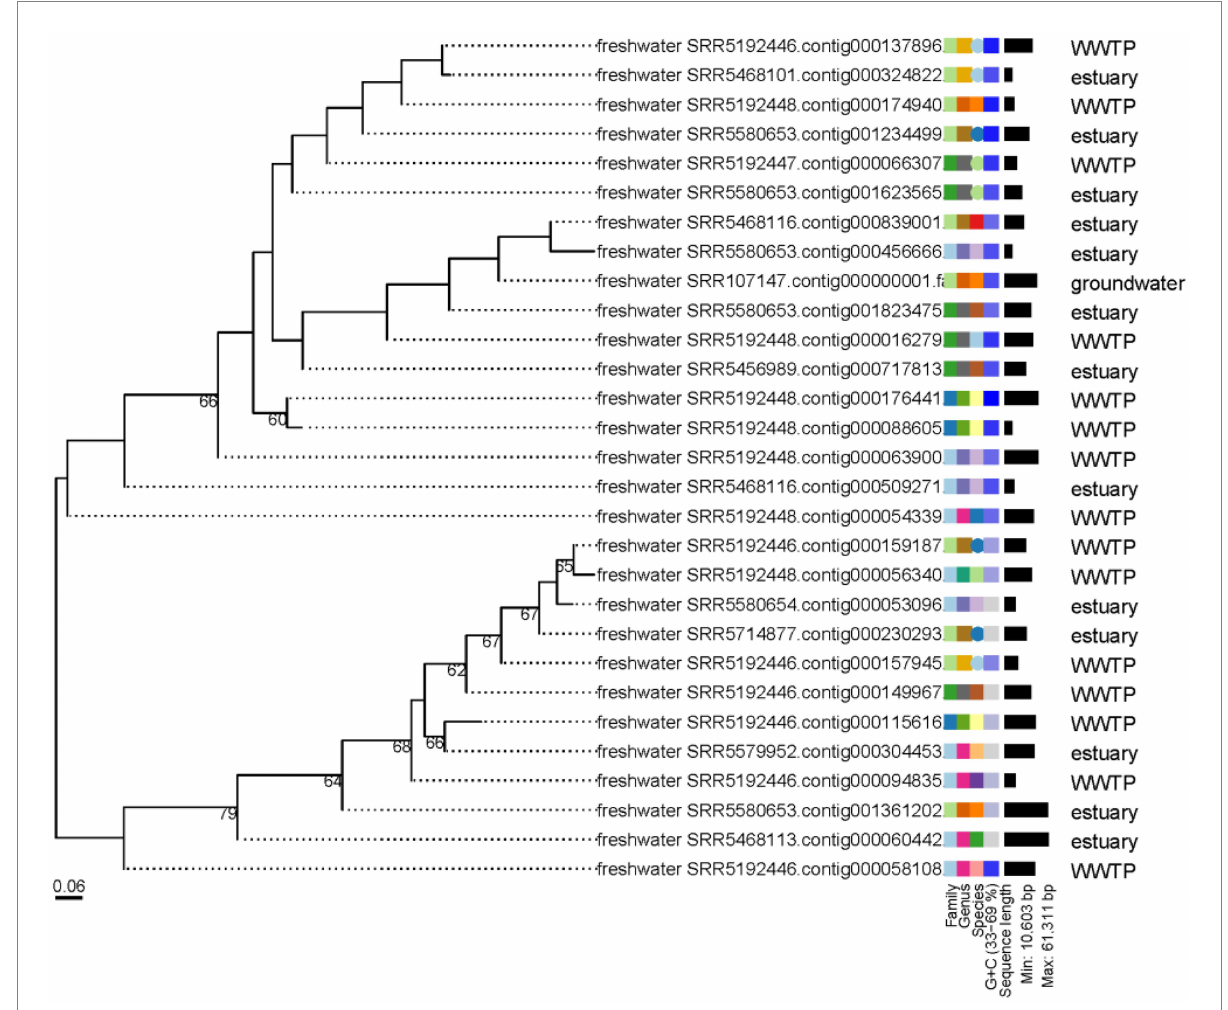
FIGURE 4 Phylogenomic tree of the 29 contigs with nonzero abundance among all studied biomes. The numbers above branches are GBDP pseudo- bootstrap support values from 100 replications. The branch lengths of the resulting VICTOR tree are scaled in terms of the D4 distance formula